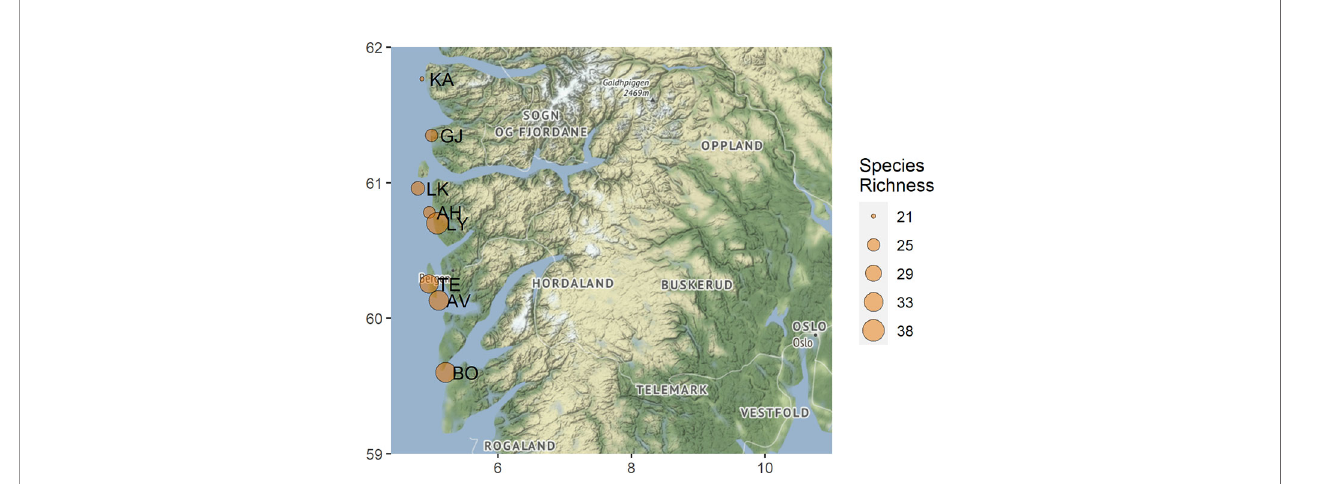
FIGURE 1 | Map displaying the visited coastal heathland localities within western Norway. The observed OTU richness for each locality is indicated by the point size and the abbreviated locality name is found to the right of each point. AV, Austevoll; AH, Austrheim; BO, Bømlo; GJ, Gjerdevik; KA, Kalvåg; LK, Litle Kvernøy; LY, Lygra; TE, Televåg.